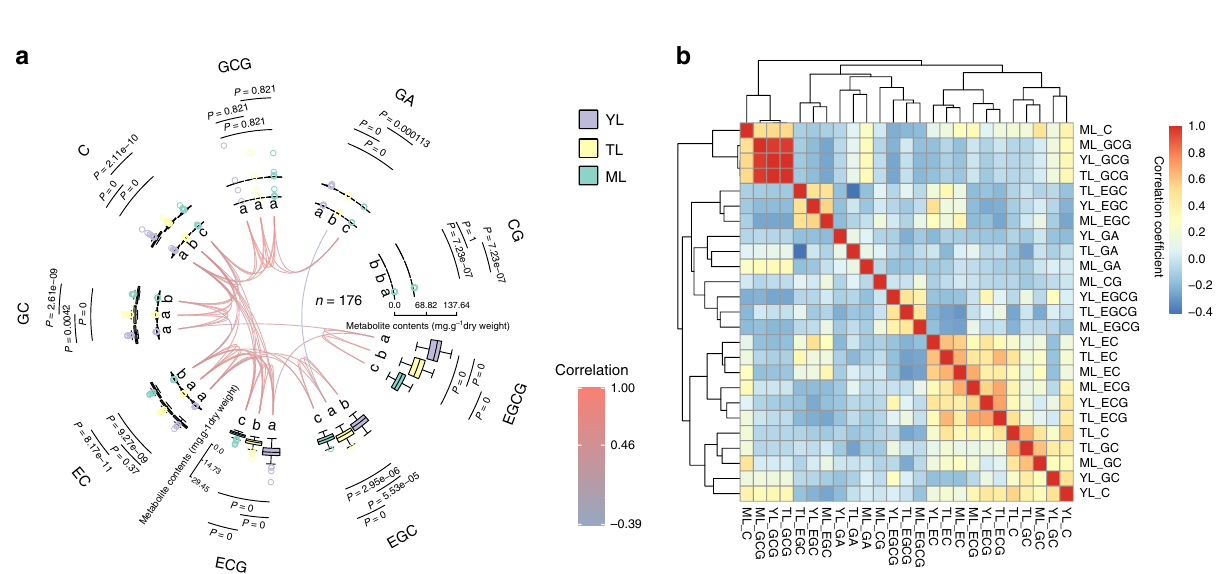
Fig. 3 Catechin and gallic acid pro fi les of tea population. a Catechin and GA contents of tea accessions in different leaf tissues. The outside boxplots indicate the contents of catechins in three different leaf samples (YL: young leaf; TL: third leaf; ML: mature leaf; mg g − 1 dry weight). The median is indicated by the middle line of the box, the lower and upper boundaries show the fi rst (25%) and third (75%) quartiles and the whiskers represent the minimum and maximum values, excluding outliers. The points outside the whiskers represent the outliers. Letters represent the signi fi cant levels of posthoc (adjusted P < 0.01; Tukey ’ s test; two sided). Links indicate the signi fi cant correlations among catechins and colors show the correlation coef fi cients. b Heatmap of correlation of catechins and gallic acid in different leaf